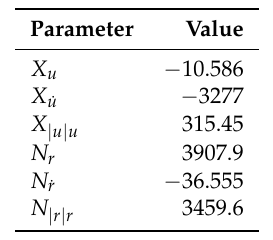
Table 4. Parameter estimation results for the surge and yaw motion